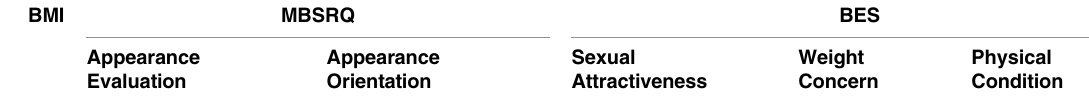
Table 2. Correlation between the results of BSE and MBSRQ in women with various BMI.